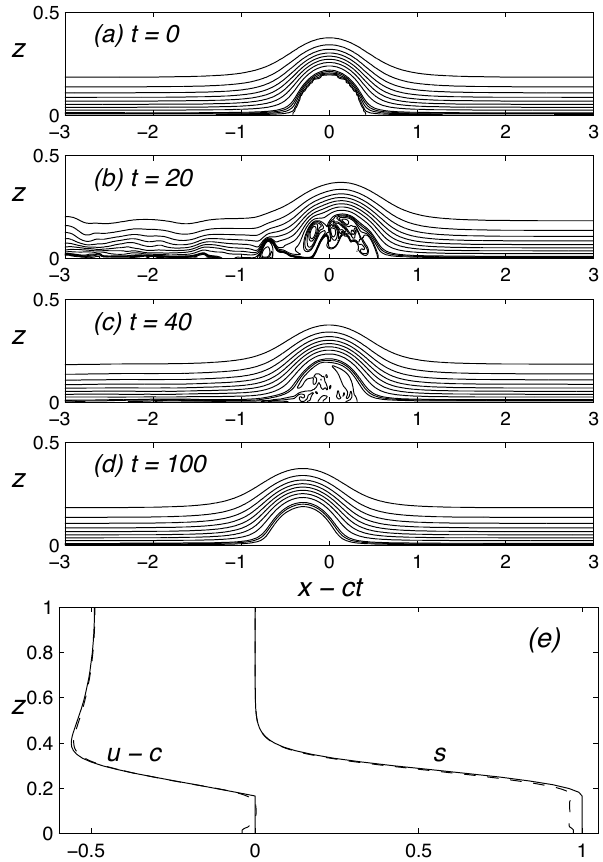
Fig. 11. Evolution of a stagnant-core DJL solution for λ = 8, s c = 1 . 1, and c = 0 . 4. (a) – (d) Contours of s are shown in at the times indicated. The contour intervals are 0.1 for s ≤ 0 . 9 and 0.025 for s > 0 . 9. Note that only the lower half of the domain is shown. (e) Comparison of u − c and s at the wave crest at t = 100 (dashed) with the stagnant-core DJL solution with λ = 8, s c = 1 and c = 0 . 394